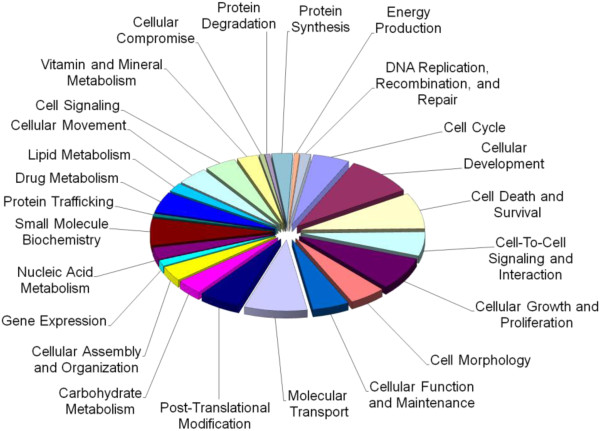
Molecular and cellular functions associated with genes differentially expressed in AD brain irrespective of severity (55 genes). The chart shows the number of genes, expressed as a percentage of the total number, involved in each of the molecular and cellular functions deemed significant by IPA Ingenuity.